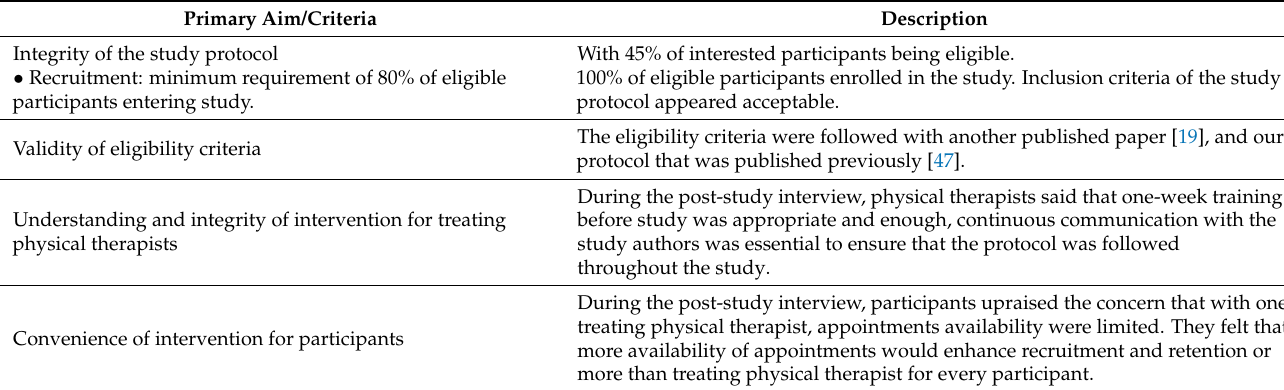
Table 3. Results of primary aim